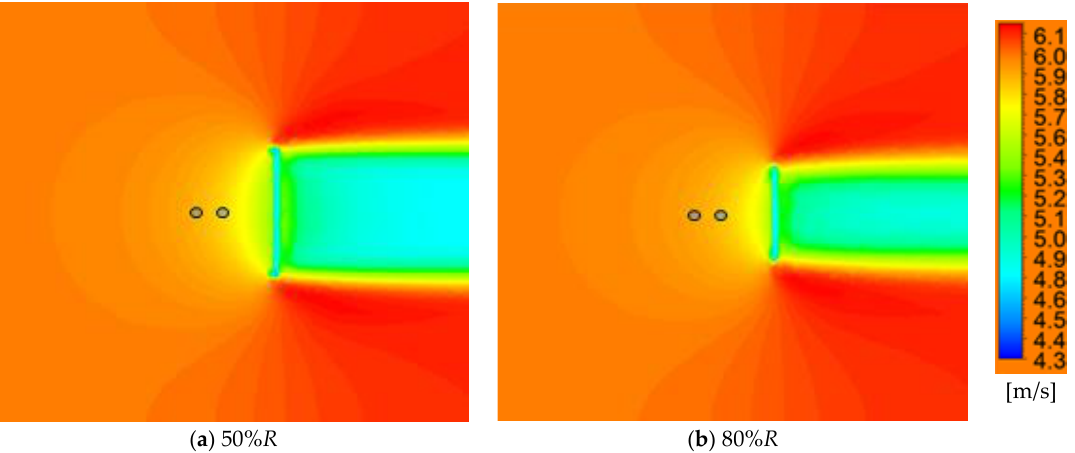
Figure 9. Wind speed distribution in front of the rotor at C T = 0.4, U 0 = 6 m/s. (The circles indicate the dummy tower positions at −6 D T and −4 D T ).